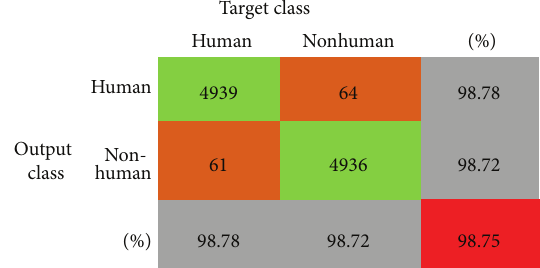
Figure 9: Confusion matrix of the overall performance.